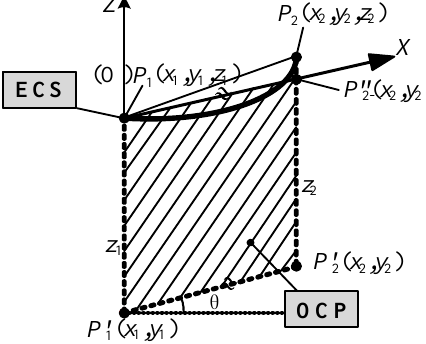
Figure 9. The construction of OCP and ECS.